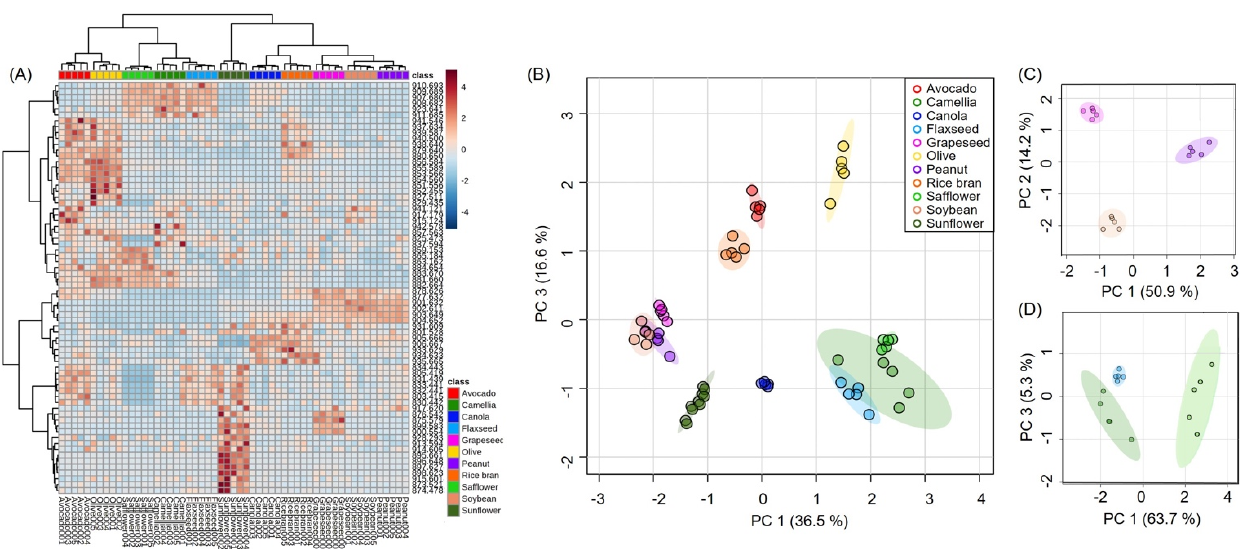
Figure 5. ( A ) Heatmap visualization constructed using 70 TAG features. Rows represent TAG features; columns represent samples prepared using AgNPts and the spray solution method. ( B ) PCA score plot for eleven edible oils based on the SALDI-MS results. The first and third principal components accounted for 36.5% and 16.6% of the variance, respectively. PCA score plot for ( C ) group 1 and ( D ) group 2. For group 1, the first and second principal components accounted for